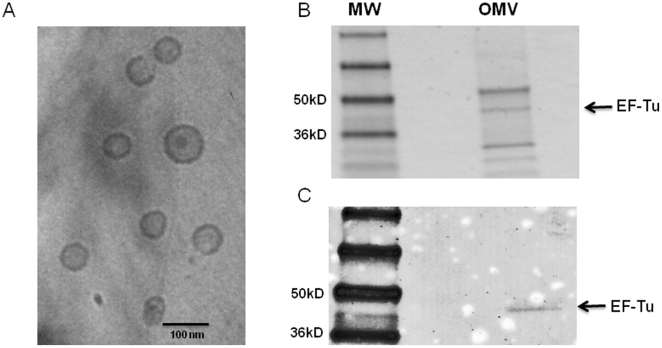
EF-Tu is present in B. pseudomallei outer membrane vesicles.(A) Cryo-transmission electron micrograph of purified OMVs prepared from a late logarithmic culture of B. pseuodomallei strain 1026b. Bar indicates 100 nm. (B) Coomassie-stained gel of OMV preparation (5 µg); MW = SeeBlue plus2 molecular weight ladder. (C) Western blot of OMV preparation using affinity purifed EF-Tu antibody (1∶1000).